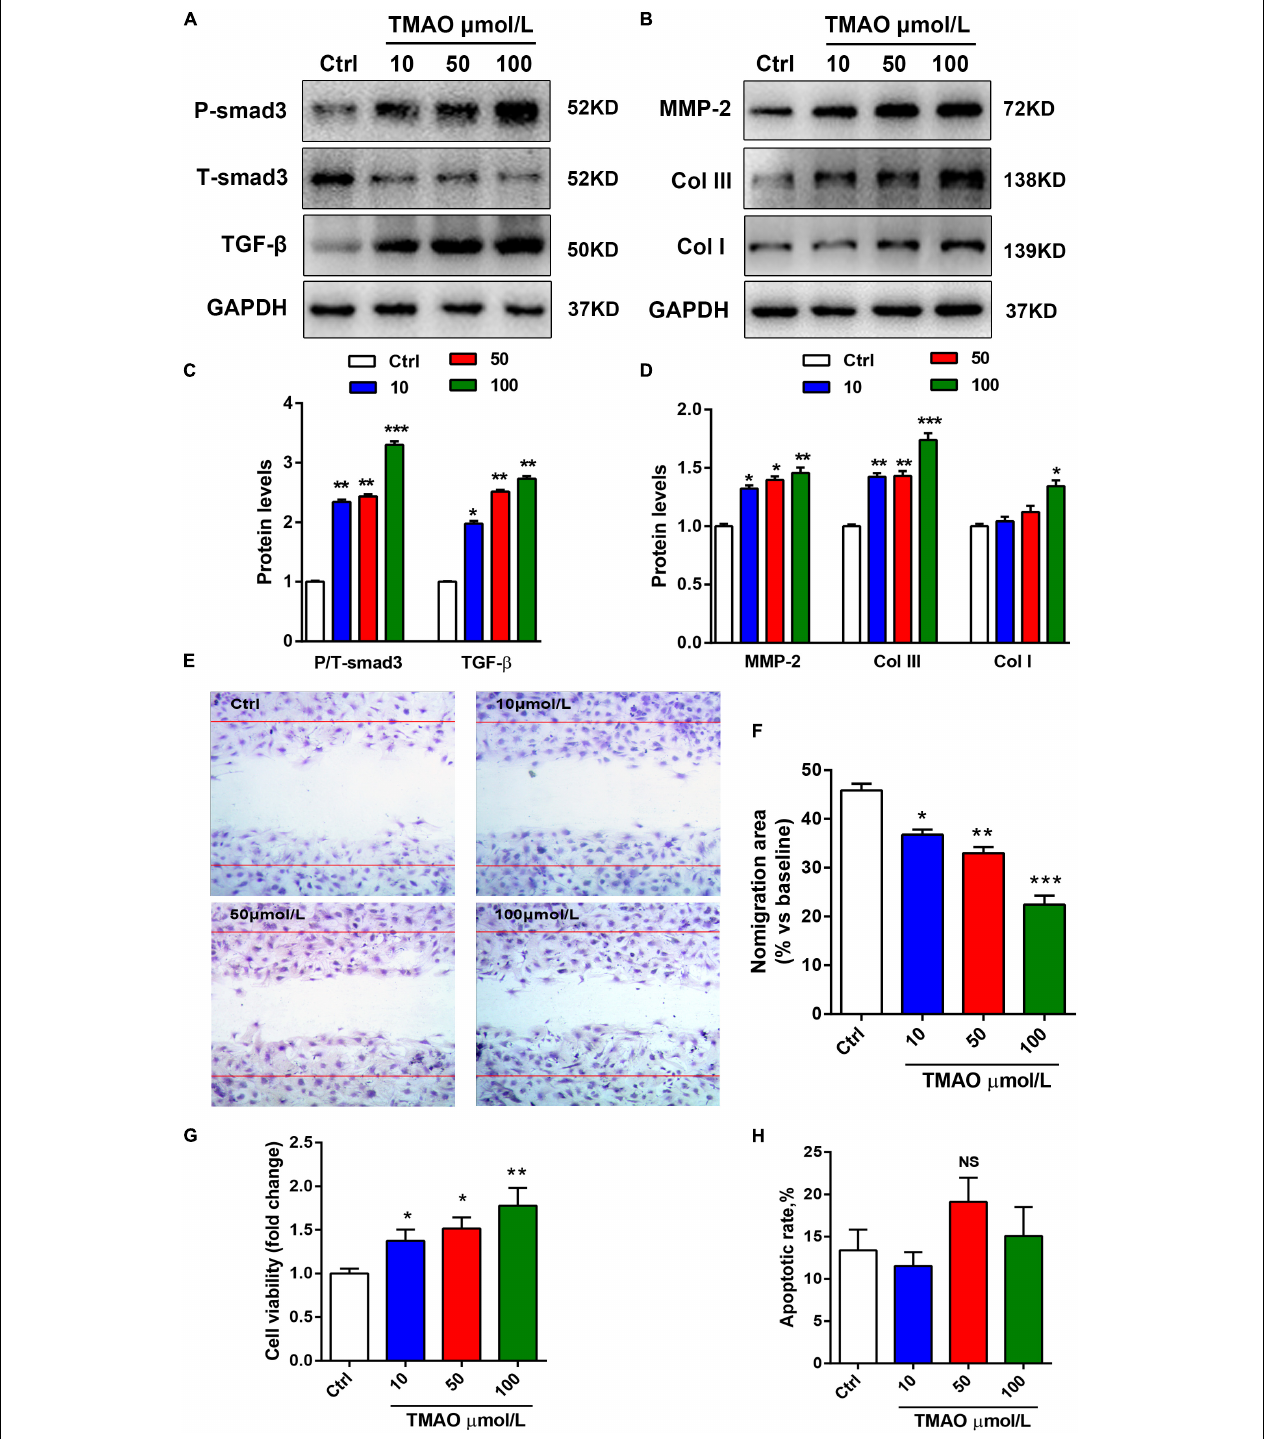
FIGURE 3 | TMAO induced cardiac fibroblast proliferation, migration and collagen deposition in a dose-dependent manner. (A) P-Smad3, T-Smad3, TGF- β , MMP-2, Col I, and Col III (B) protein expression was analyzed by western blotting and quantified (C,D) according to immunoblotting (the ratio of protein pixel density/GAPDH pixel density) following different doses of TMAO exposure. (E) Scratch assays showing the migration ability of cardiac fibroblasts for 24 h under 200 × magnification. (F) Quantification of the percentage of the migration area. (G) CCK-8 assay showing the proliferation of cardiac fibroblasts subjected to TMAO at different doses. (H) Quantification of the apoptotic rate of cardiac fibroblasts by an Annexin Apoptosis Detection Kit APC assays. All data were analyzed at least three times. Mean ± SD. ∗ P < 0.05, ∗∗ P < 0.01, ∗∗∗ P < 0.001 (vs. Control).